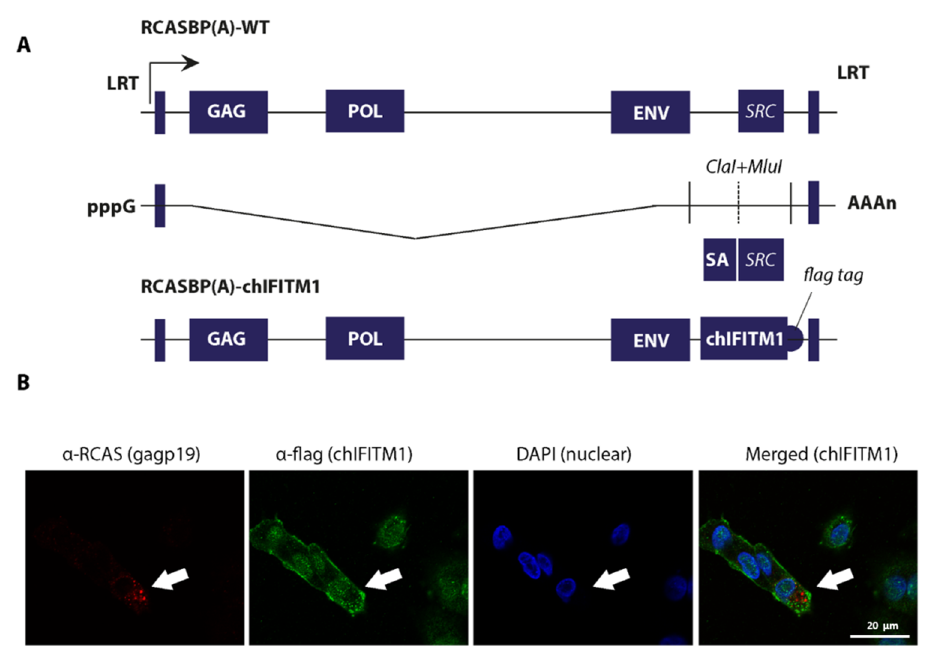
Figure 1. Generation and rescue of recombinant retroviruses expressing chIFITM1. ( A ) A schema for the generation of recombinant RCASBP virus in which src gene was replaced with chIFITM1. ( B ) Retroviruses were rescued in DF-1 cells and stained for retroviral structural gag protein and flag-tagged fused to the chIFITM1.